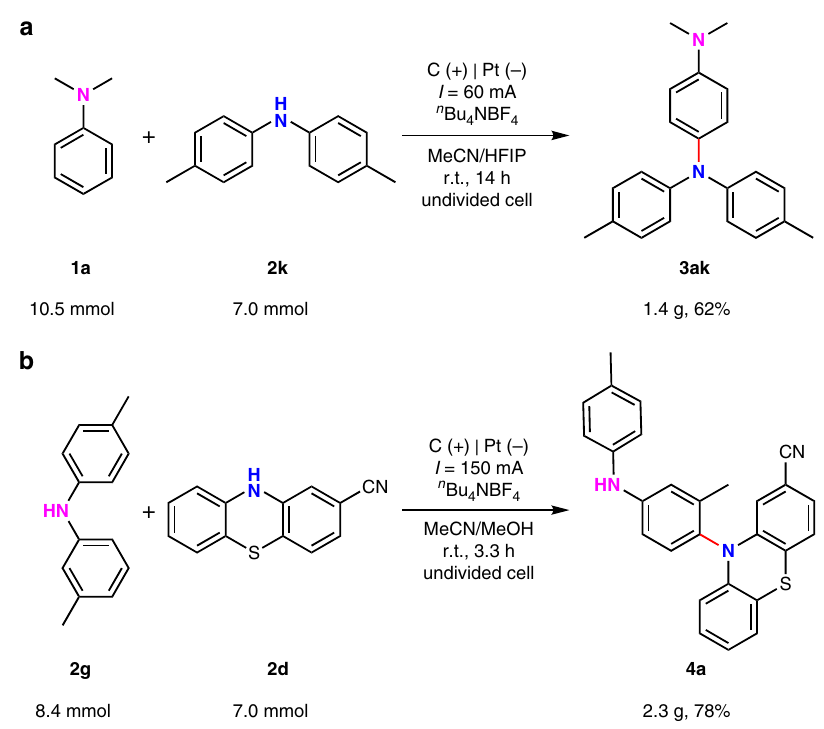
Fig. 5 Large scale synthesis. a Gram-scale synthesis of 3ak . b Gram-scale synthesis of 4a